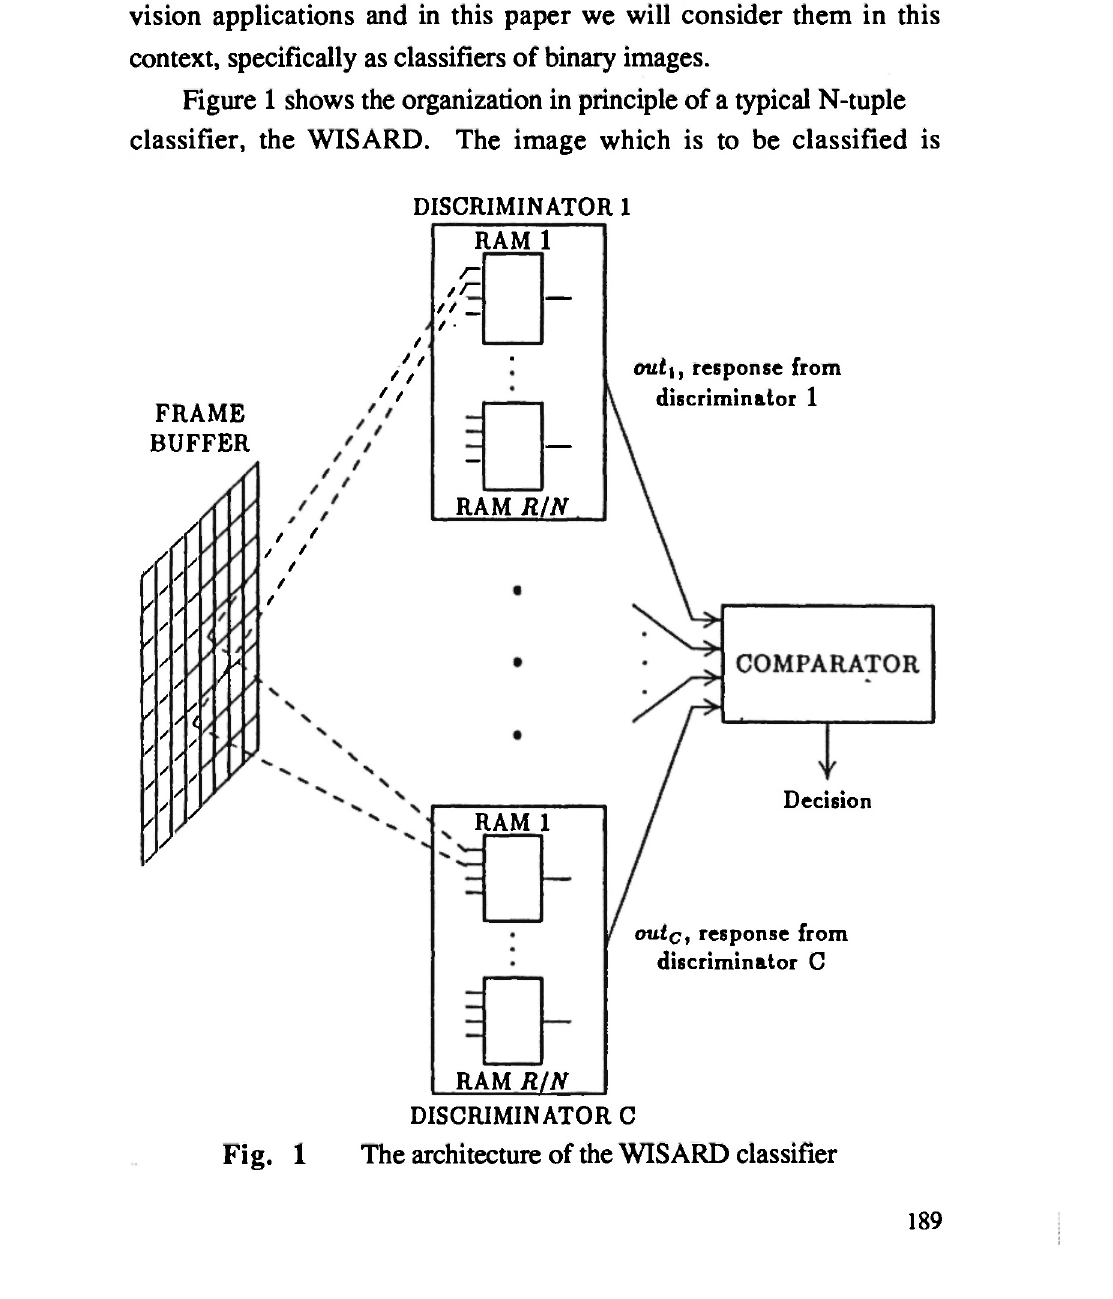
Fig. 1 The architecture of the WISARD